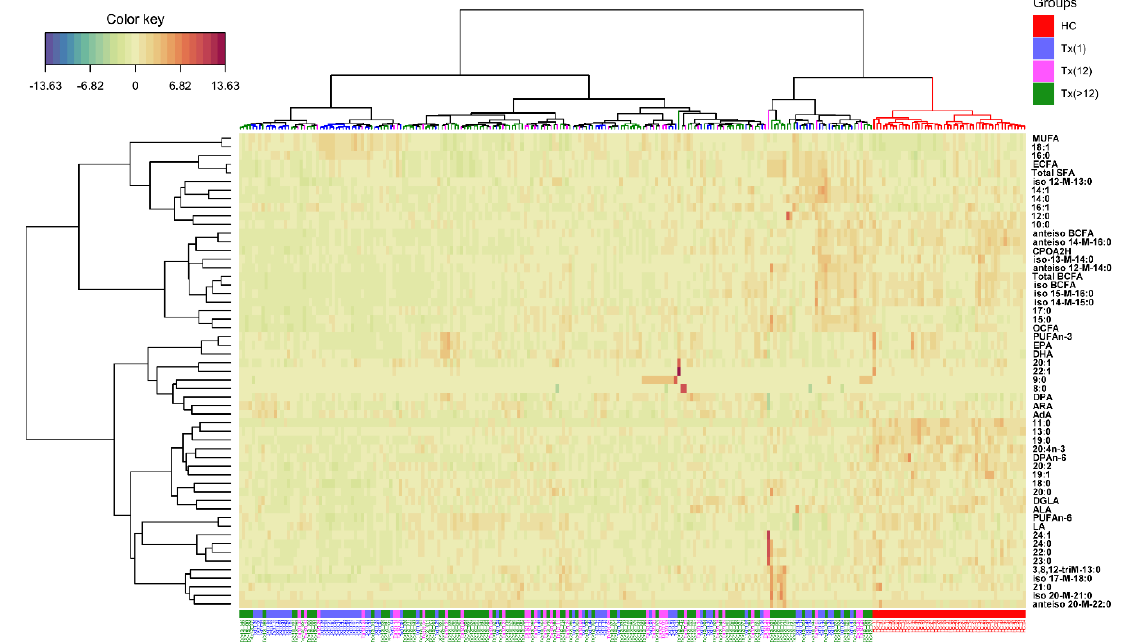
Figure 3. Heatmap generated basing on the serum profile of 55 fatty acids in healthy control (HC, red) and Tx patients. Rows: fatty acids; columns: individuals. Color key indicates fatty acid expression value: dark blue: lowest; dark red: highest. HC – healthy controls; Tx(1)-patients up to one month after the procedure; Tx (12)-patients between 1 month and the first year post-transplant; Tx (>12)-patients in their consecutive years post-transplant. AdA-adrenic acid; ALA- α -linolenic acid; ARA-arachidonic acid; BCFA-branched chain fatty acids; CPOA2H-cyclopropaneoctanoic acid 2-hexyl; DGLA-dihomo- γ -linolenic acid; DHA-docosahexaenoic acid; DPAn6-docosapentaenoic acid n6; DPA-docosapentaenoic acid n3; ECFA-even chain fatty acids; EPA-eicosapentaenoic acid; ETA-eicosatetraenoic acid; LA-linoleic acid; MUFA-monounsaturated fatty acids, OCFA-odd chain fatty acids; PUFA-polyunsaturated fatty acids; SFA-saturated fatty acids.